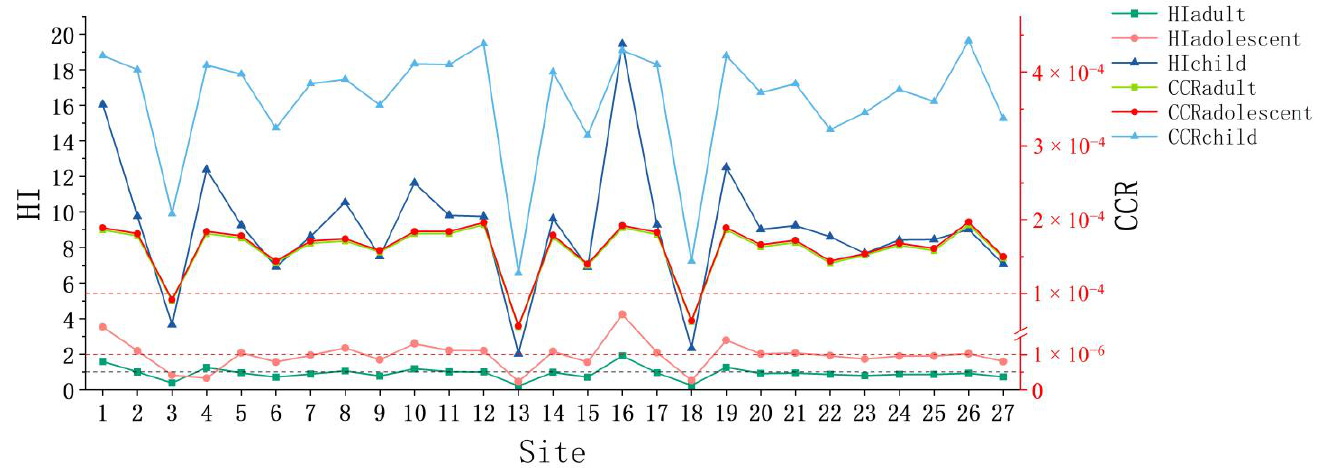
Figure 6. HI and CCR for the contamination of PTEs overall for adults, adolescents and children. The three reference lines in Figure 6 are, in order of meaning from bottom to top: the reference line for HI = 1, the reference line for CCR = 10 −6 and the reference line for CCR = 10 −4 .